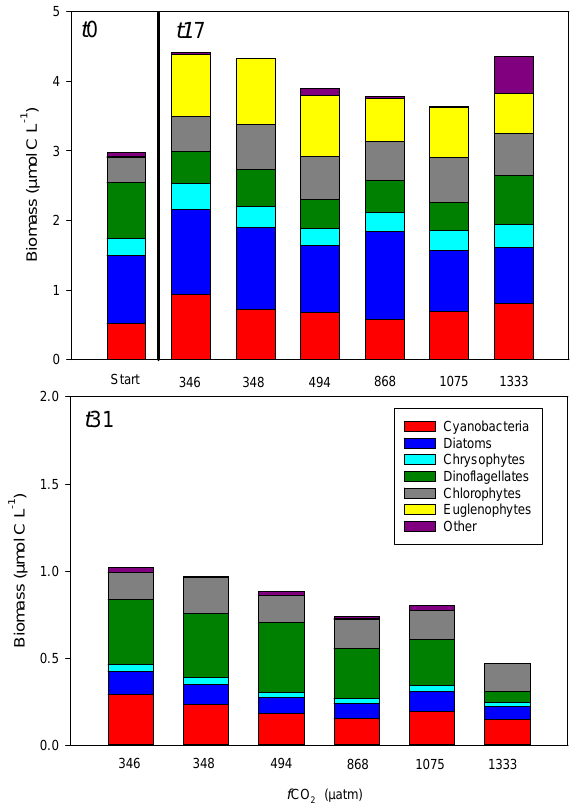
Figure 1. The main phytoplankton groups at the start of the exper- iment, t 0, and t 17 (upper panel) and t 31 (lower panel). The initial ( t 0) was the average of all mesocosm bags. A more detailed descrip- tion of the temporal development in the phytoplankton community can be found in Bermúdez et al.